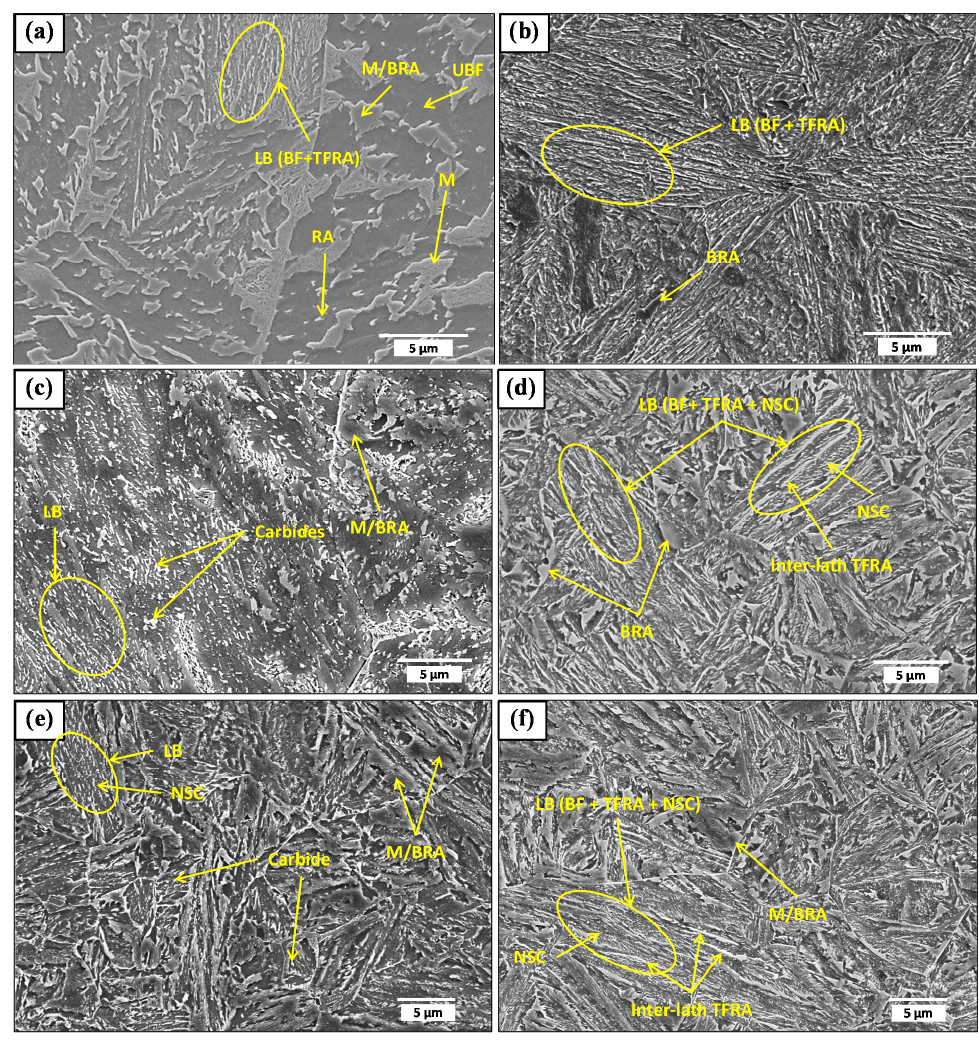
Figure 8. SEM images of all bainitic steels; ( a ) B360-AR, ( b ) B360-HT, ( c ) B1400-AR, ( d ) B1400-HT, ( e ) CrB-AR, ( f ) CrB-HT.